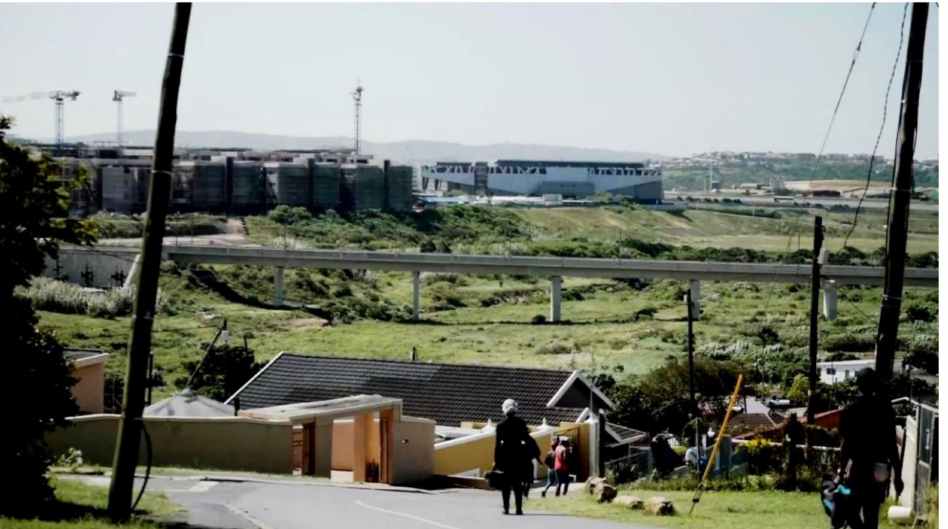
Figure 2. View from the KwaMashu residential area towards the new Bridge City development taken across the Piesang’s River flood plain. Only the train bridge crosses the vast wetland that has become an insurmountable barrier to pedestrians. Source: Gesellschaft fur Zusammenarbeit (GIZ), 2018. One of the challenges for the Bridge City development has been precisely the crossing of the Piesang’s River flood plain [61]. Over a length of nearly 2 km, there is no pathway or pedestrian bridge over the Piesang’s River to allow the population of old-town KwaMashu to safely cross the river and steep slopes to reach the facilities of Bridge City [65]. Addi- tionally, part of the protected biodiversity of the Durban MOSS green space is in a state of neglect and is perceived to be a dangerous, no-go area (see Figure 3).